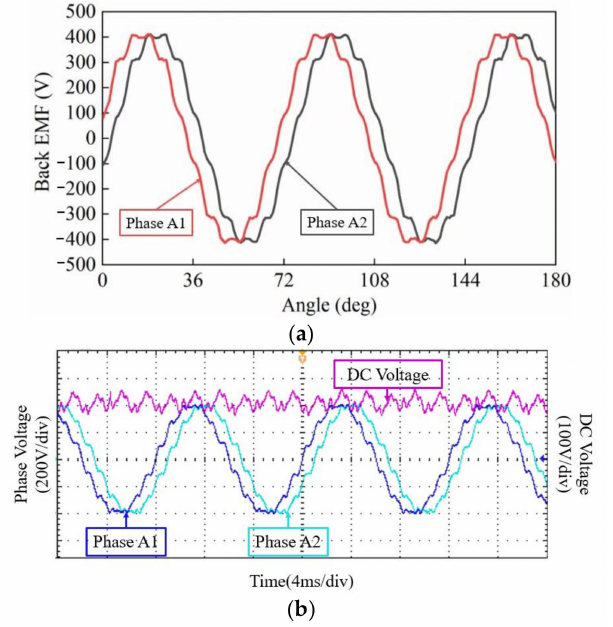
Figure 12. Back EMF of A1 and A2 phases. ( a ) FEA results; ( b ) experimental